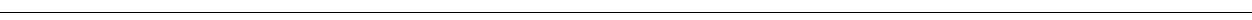
Fig. 4 Lateral diffusion and distance dependence of membrane proteins relative to MCC/eisosomes. a Reconstruction of the trajectories: bright areas correspond to eisosomes, green Xs mark starting point of Can1 trajectory and purple lines show the trajectories. b Table summarizing diffusive behavior of Can1 (with arginine ( n = 47) and without arginine ( n = 35) in the medium), Nha1 ( n = 52), and Pma1 ( n = 129). *refers to fraction of peaks localized in the inter-eisosomal distance. c Cartoon showing the location of Can1 (red), Nha1 (light blue), and Pma1 (orange) relative to a MCC/eisosome and the intensity pro fi les of the fl uorescent foci. The further away from the focal plane, the wider and dimmer the signal, which is seen in the intensity pro fi les of the peaks (green dotted lines indicate detection limit). Measuring the full width at half maximum (FWHM) of the peaks gives information about focal depth and thus the position of proteins in the MCC/eisosome; the extra peak at FWHM of 650 nm in panel d indicates that Can1 enters the MCC/eisosome in the z- direction. The panels d – j show the histograms of FWHM of Can1 of peaks detected at 25 – 50 nm ( d ), 50 – 75 nm ( e ), 75 – 100 nm ( f ), 100 – 125 nm ( g ), or 25 – 125 nm ( h ) from the centroid of the nearest MCC/eisosome; the percentages indicate the fraction of proteins at a given distance. The intensity pro fi les at 0 – 25 nm were too low to assign them con fi dently to Can1; the histogram of all Can1 peaks is shown in panel i . The panels j and k show the histograms of FWHM of Pma1 (orange) and Nha1 (light blue) at 25 – 50 nm from the centroid of the nearest MCC/eisosome ( j ) and of all the peaks ( k ); n